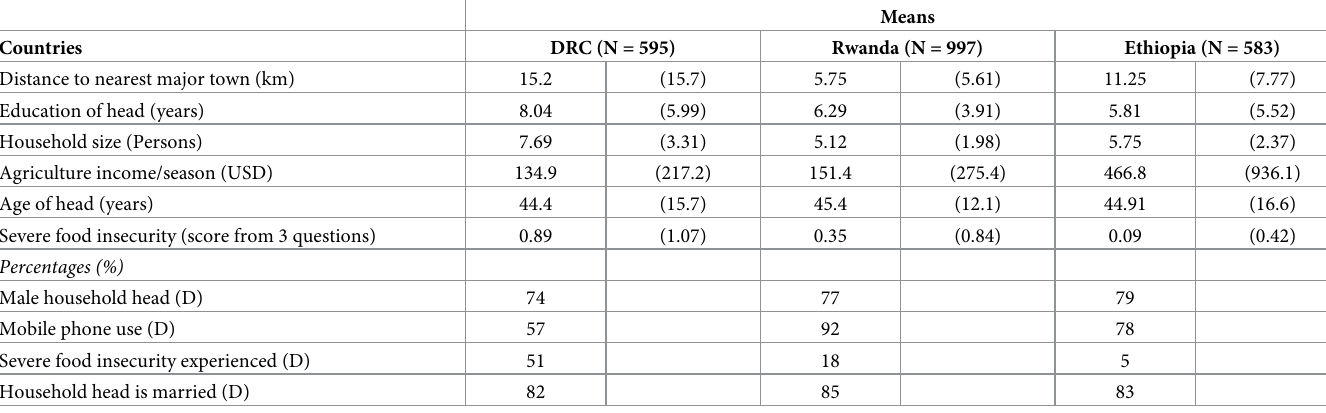
Table 2. Description of variables used in